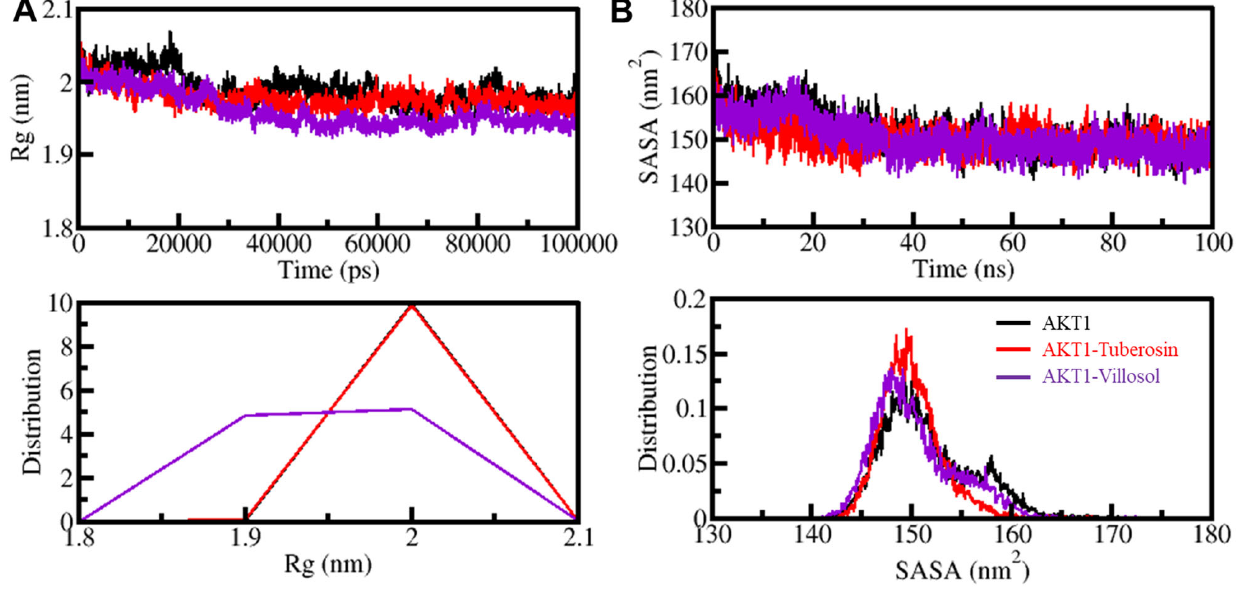
Figure 4. The structural compactness of AKT1 when present with tuberosin and villosol binding as a function of time. ( A ) The radius of gyration ( Rg ) through time evaluation. ( B ) SASA plot of AKT1 as a function of time before and after binding with selected compounds. Lower graph plots depict the probability density function (PDF).